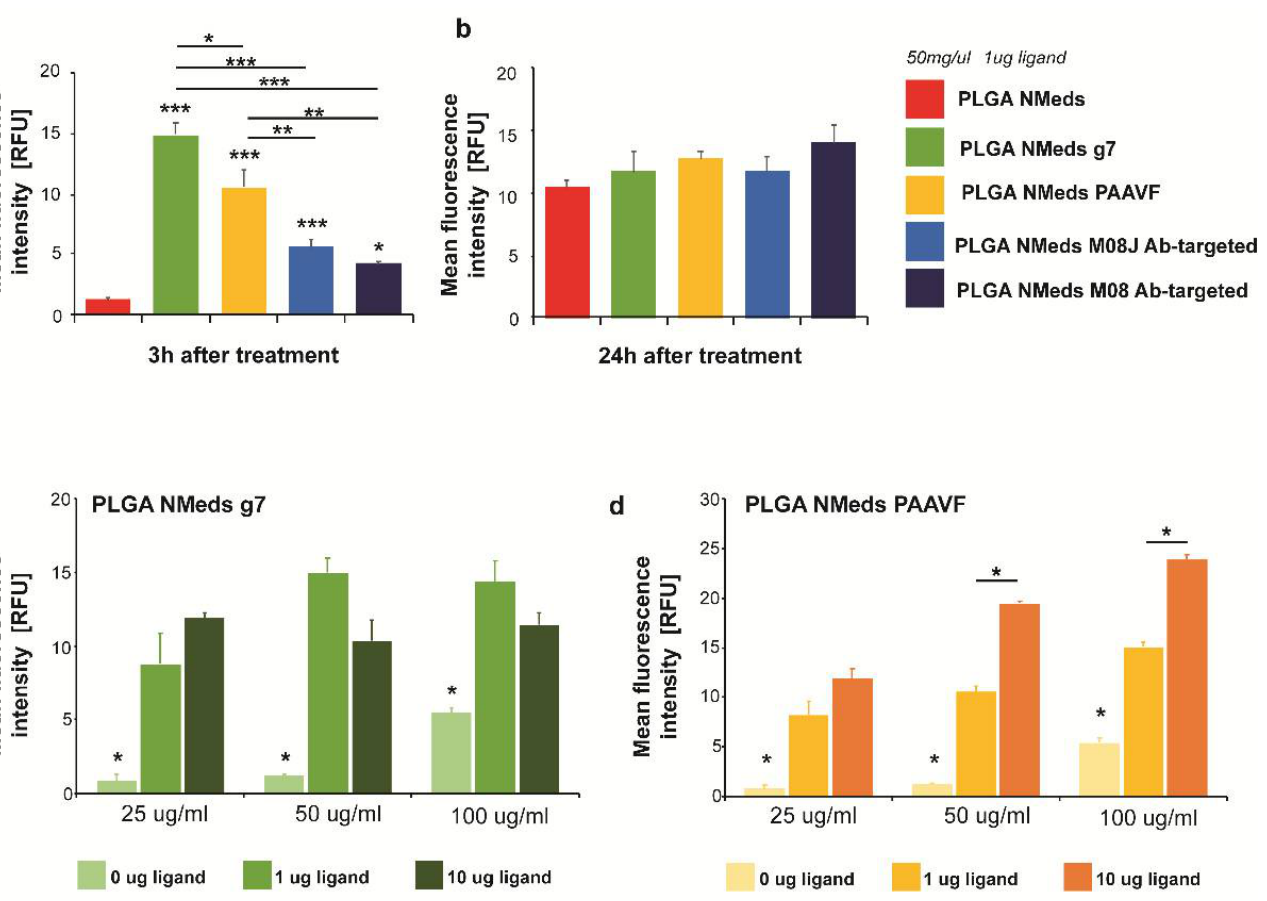
Figure 2. C6 cell uptake of 50 μg/mL targeted and non-targeted NMeds at ( a ) 3 h and ( b ) 24 h after administration. The relative fluorescence intensity of Cy5 intracellular signals (normalised to back- ground fluorescence of untreated cells) was measured in 10 cells from n = 3 samples per condition. ( c – f ) Uptake of non-modified and targeted NMeds surfaced modified with 0, 1, or 10 μg of each ligand and administered at concentrations of 25, 50, or 100 μg/mL. The relative fluorescence inten- sity of Cy5 intracellular signals (normalised to background fluorescence of untreated cells) was measured in 10 cells from n = 3 samples per condition. Statistical analysis was performed with one- way ANOVA and post hoc test, * p < 0.5, ** p < 0.1, *** p < 0.01. Full statistical analysis is available in Supplementary material Table S5. To maximise targeted uptake and minimise the amount of non-specific cell internal- isation, 3-h incubations were performed to test the dependence of ligand amount in the